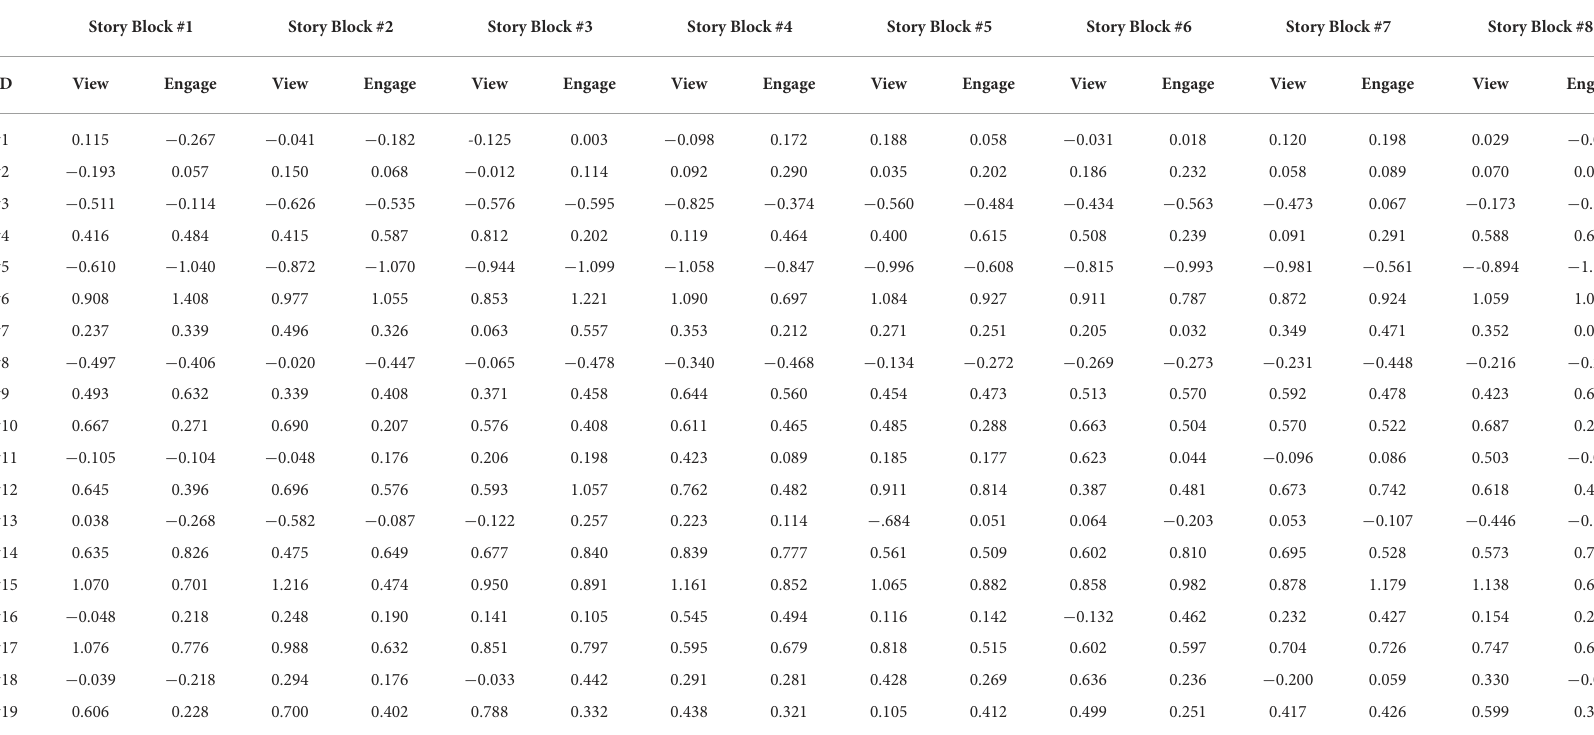
TABLE 1 The mean FAA values of the distribution of 15 FAA values, for each View and Engage Component of each story block, for each